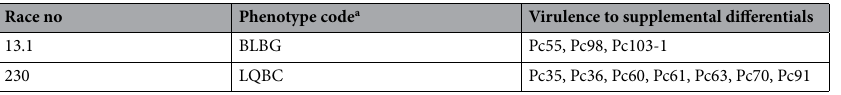
Table 1. Virulence spectrum of P. coronata f. sp. avenae pathotypes used for inoculation. a Phenotype code based on the standard differentials